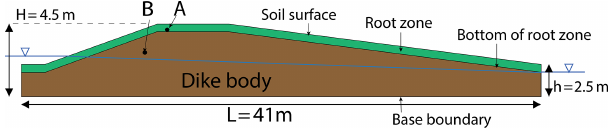
Figure 1. Geometry representing boundary, root zone layers, and points in which following results are plotted (after Jamalinia et al.,